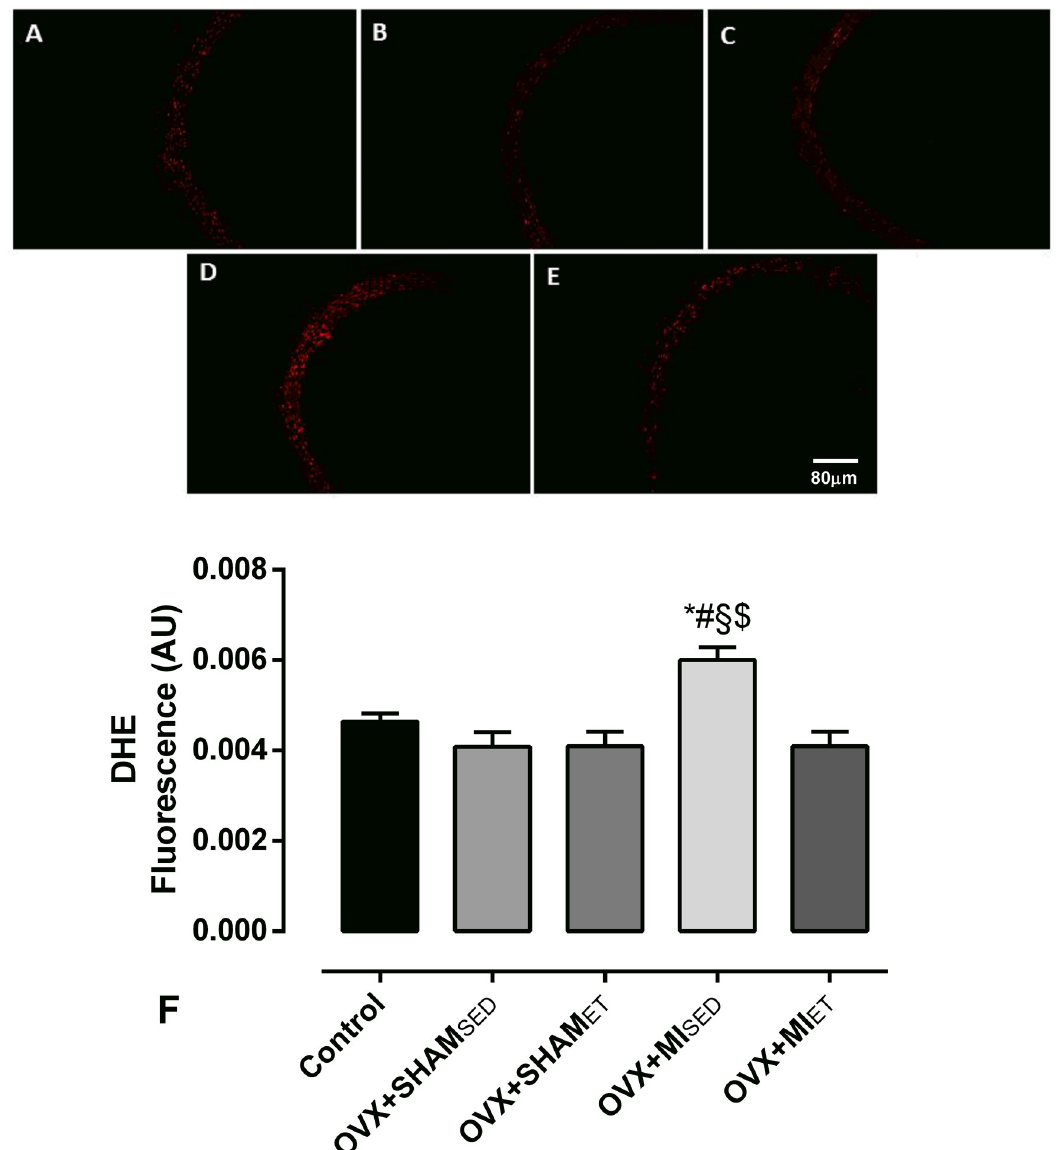
Fig 5. Evaluation of superoxide production "in situ" by micrographs depicting the fluorescence emitted by dihydroethidium in segments of the aorta vessels. Data are expressed as mean ± standard error of the mean (SEM). One-way ANOVA followed by the Fisher post-hoc test for multiple comparisons. � p < 0.05 vs Control; # p < 0.05 vs OVX+SHAM SED ; § p < 0.05 vs OVX+SHAM ET ; $ p < 0.05 vs OVX+MI ET